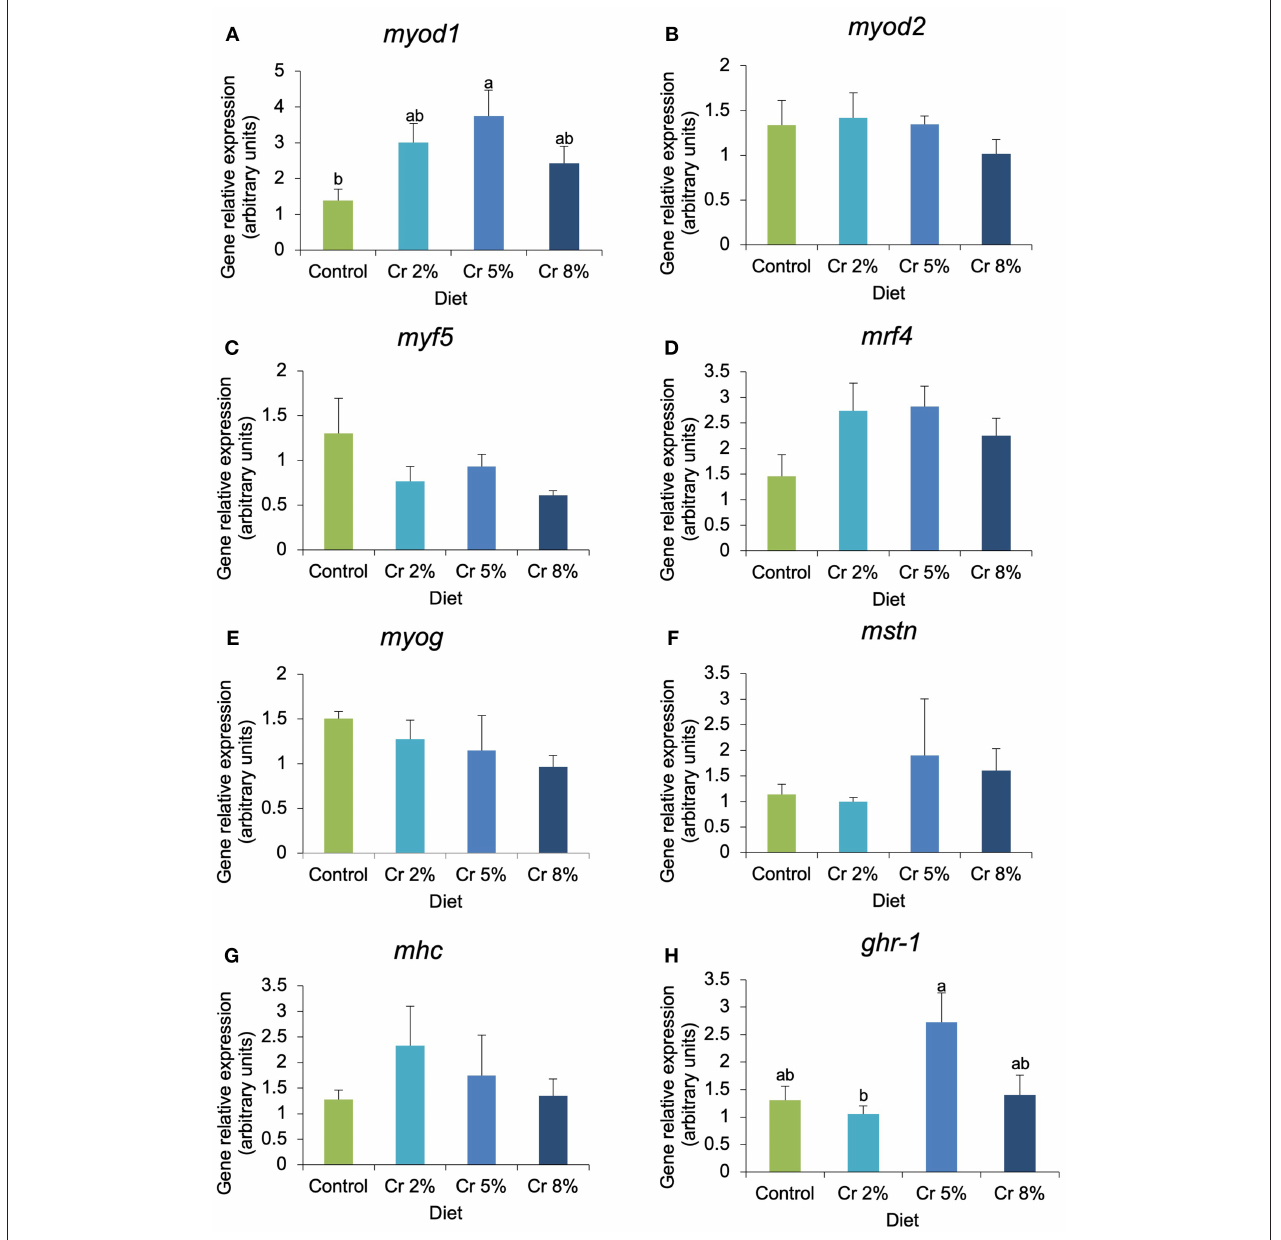
FIGURE 3 | (A–H) Relative expression of myogenic genes and markers of muscle structure and function of gilthead seabream juveniles fed the control and the experimental diets (2, 5, and 8% creatine). Different letters indicate significant differences between groups. P < 0.05. Error bars indicate the standard error for each treatment ( n =